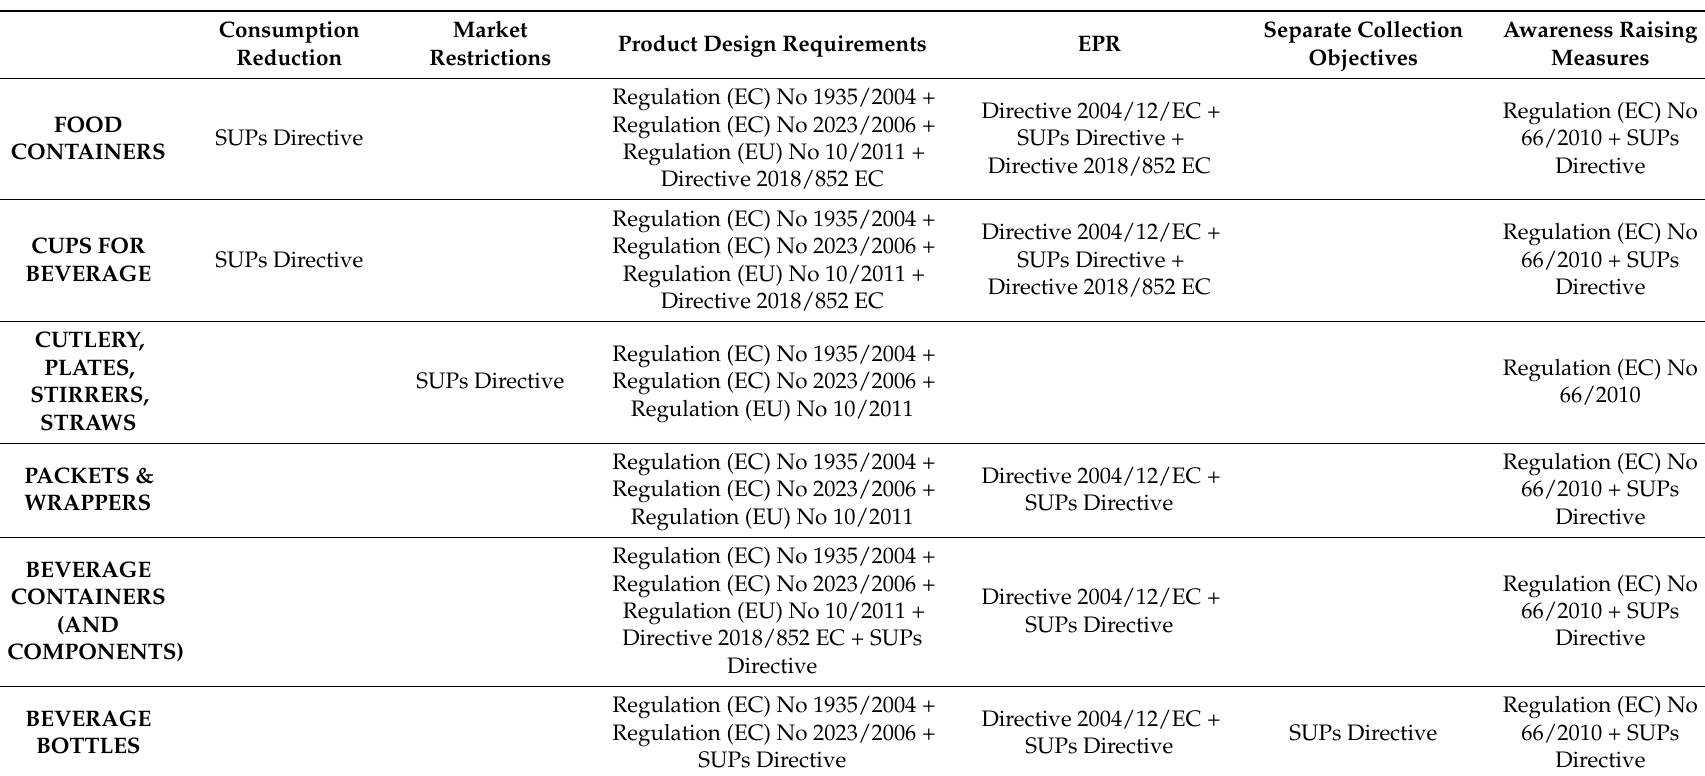
Table 3. Actions for food